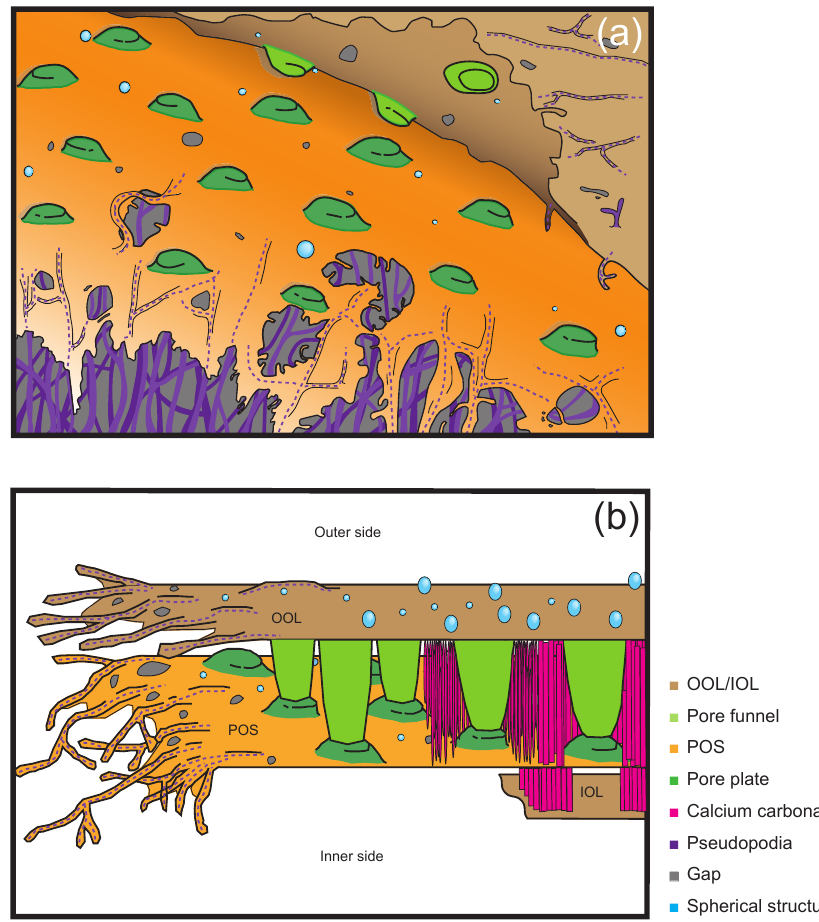
Figure 7. Schematic illustrations of chamber formation. (a) Construction of organic layers by pseudopodial weaving and subsequent gap- filling. (b) The entire chamber formation process from the initial stage on the left side to the late stage on the right side. Colour leg- end: brown = OOL/IOL; orange = POS, purple = pseudopodia/cytoplasm; light green = pore funnel on the OOL; green = pore plate; ma- genta = calcium carbonate (see Fig. 5e); blue = spherical structures; gray =